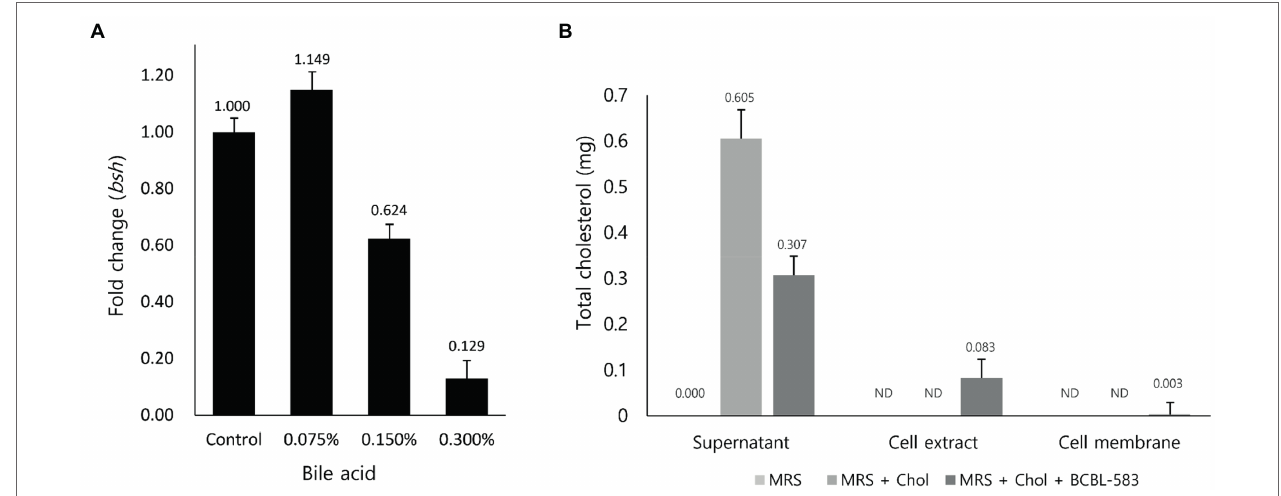
FIGURE 3 | Transcription analysis of bsh gene to bile acid and cholesterol adsorption assay of BCBL-583. (A) The bsh gene expression levels were quantified in the different concentration of bile acid by qRT-PCR. (B) To clarify the cholesterol adsorption ability of BCBL-583, total cholesterol amounts were determined in supernatant, cell extract, and cell membrane.